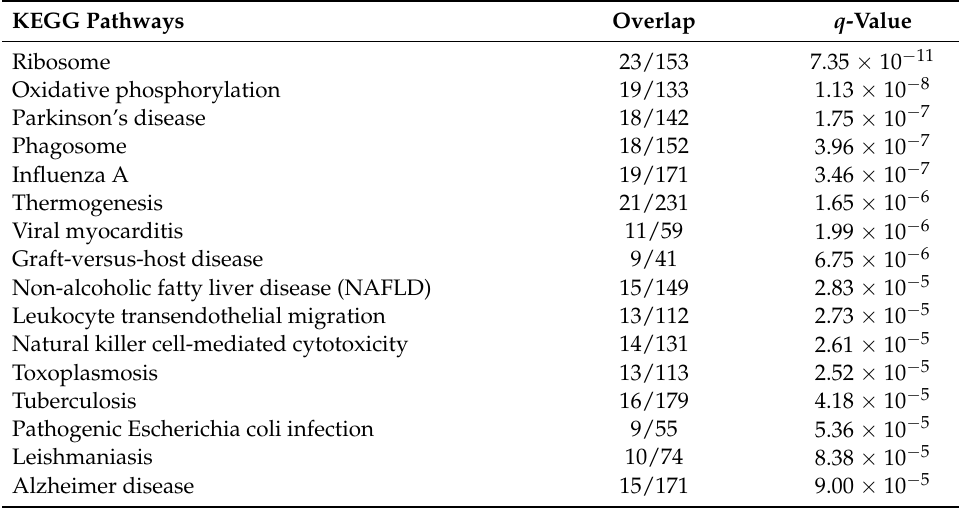
Table 1. Enriched KEGG pathways of the module